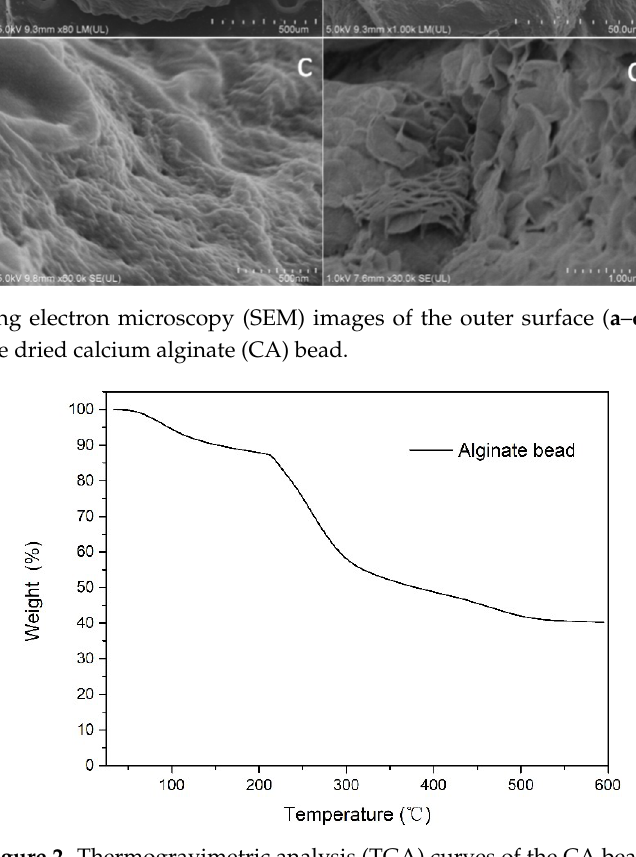
Figure 2. Thermogravimetric analysis (TGA) curves of the CA beads.